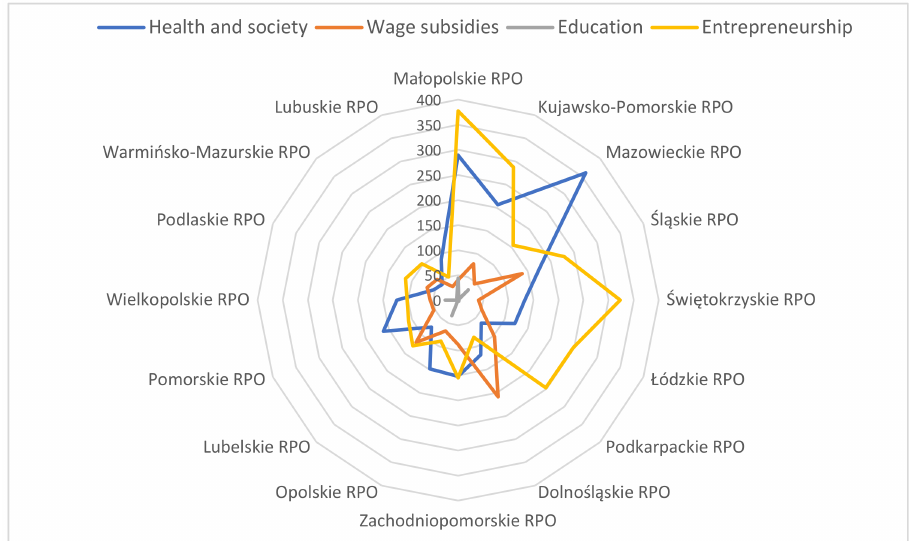
Figure 4. Structure of support for individual voivodeships, with a breakdown into support for health and society, education, entrepreneurship, and subsidies to employees’ salaries (mln